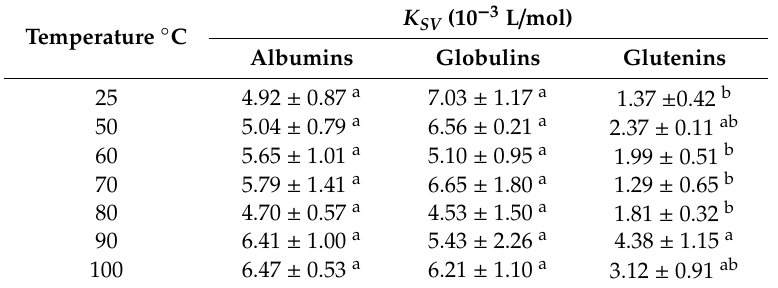
Table3. TheSternVolmerquenchingconstant( K SV )withpotassiumiodide(KI)atdi ff